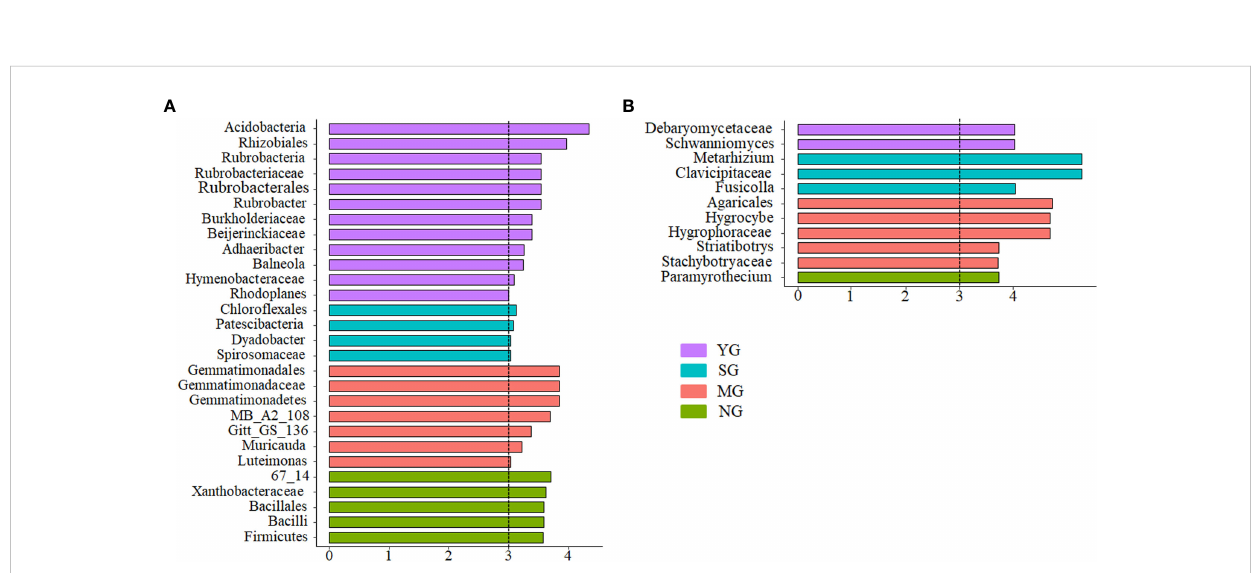
FIGURE 3 Indicator bacteria with LDA scores of 3 or greater in bacterial communities under different herbivore assemblages (A) ; indicator fungi with LDA scores of 3 or greater in fungal communities under different herbivore assemblages (B) . YG, Yak grazing; SG, Tibetan Sheep grazing; MG, Yak and Tibetan sheep mixed grazing; NG, No